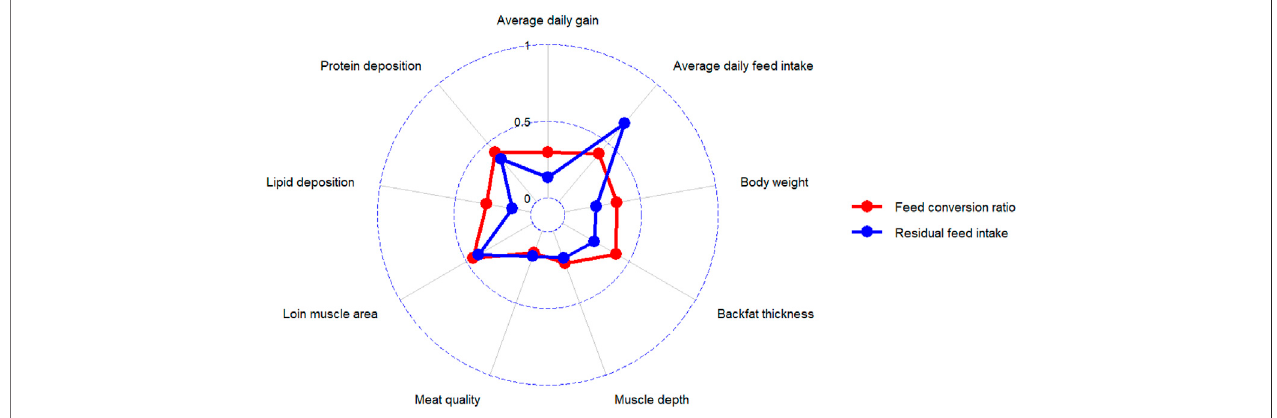
FIGURE 2 | The average absolute values of genetic correlations of RFI and FCR with other economically important traits in pig.